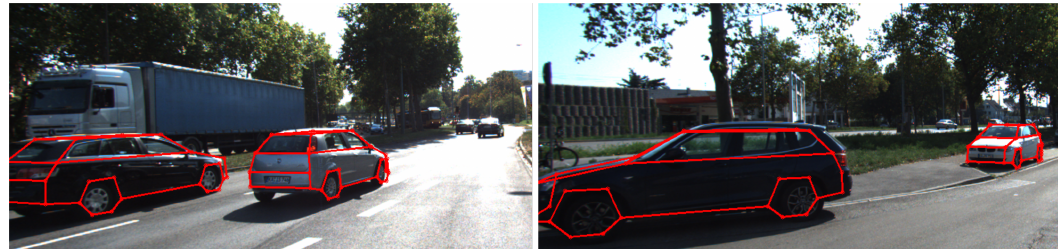
Figure 18. Estimated vehicle models backprojected to the image. ( Left ): models assessed to moving cars; ( Right ): models assessed to parked